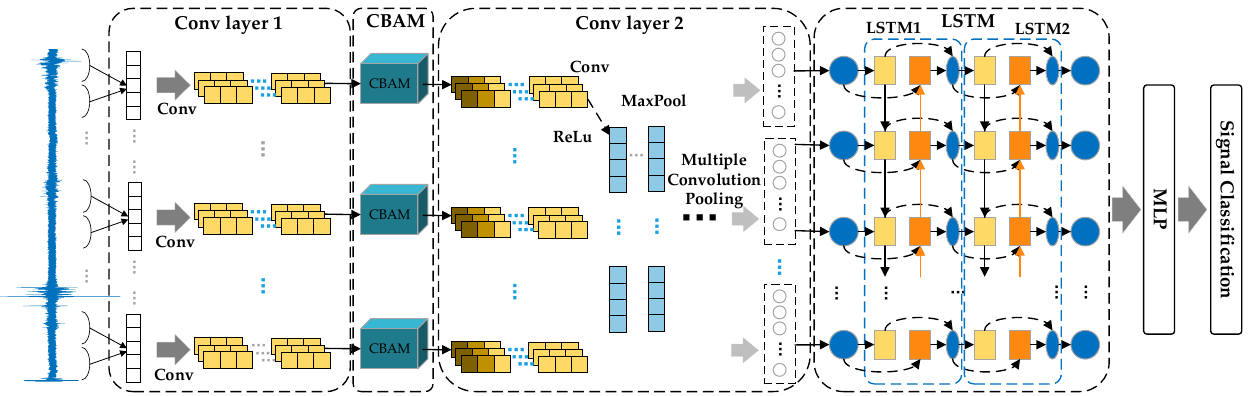
Figure 7. CNN-CBAM-LSTM network flow chart.